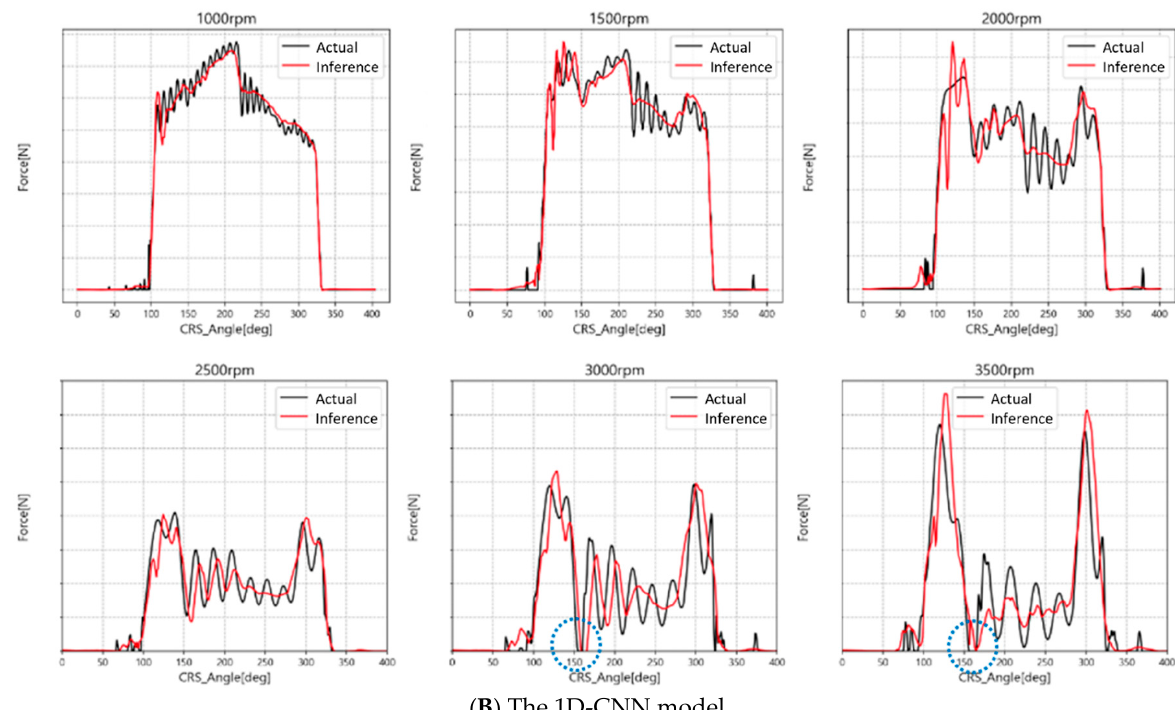
Figure A1. Chart comparing the actual and predicted values of the valve train force by crank angle reference RPM using the GBRT and 1D-CNN models.